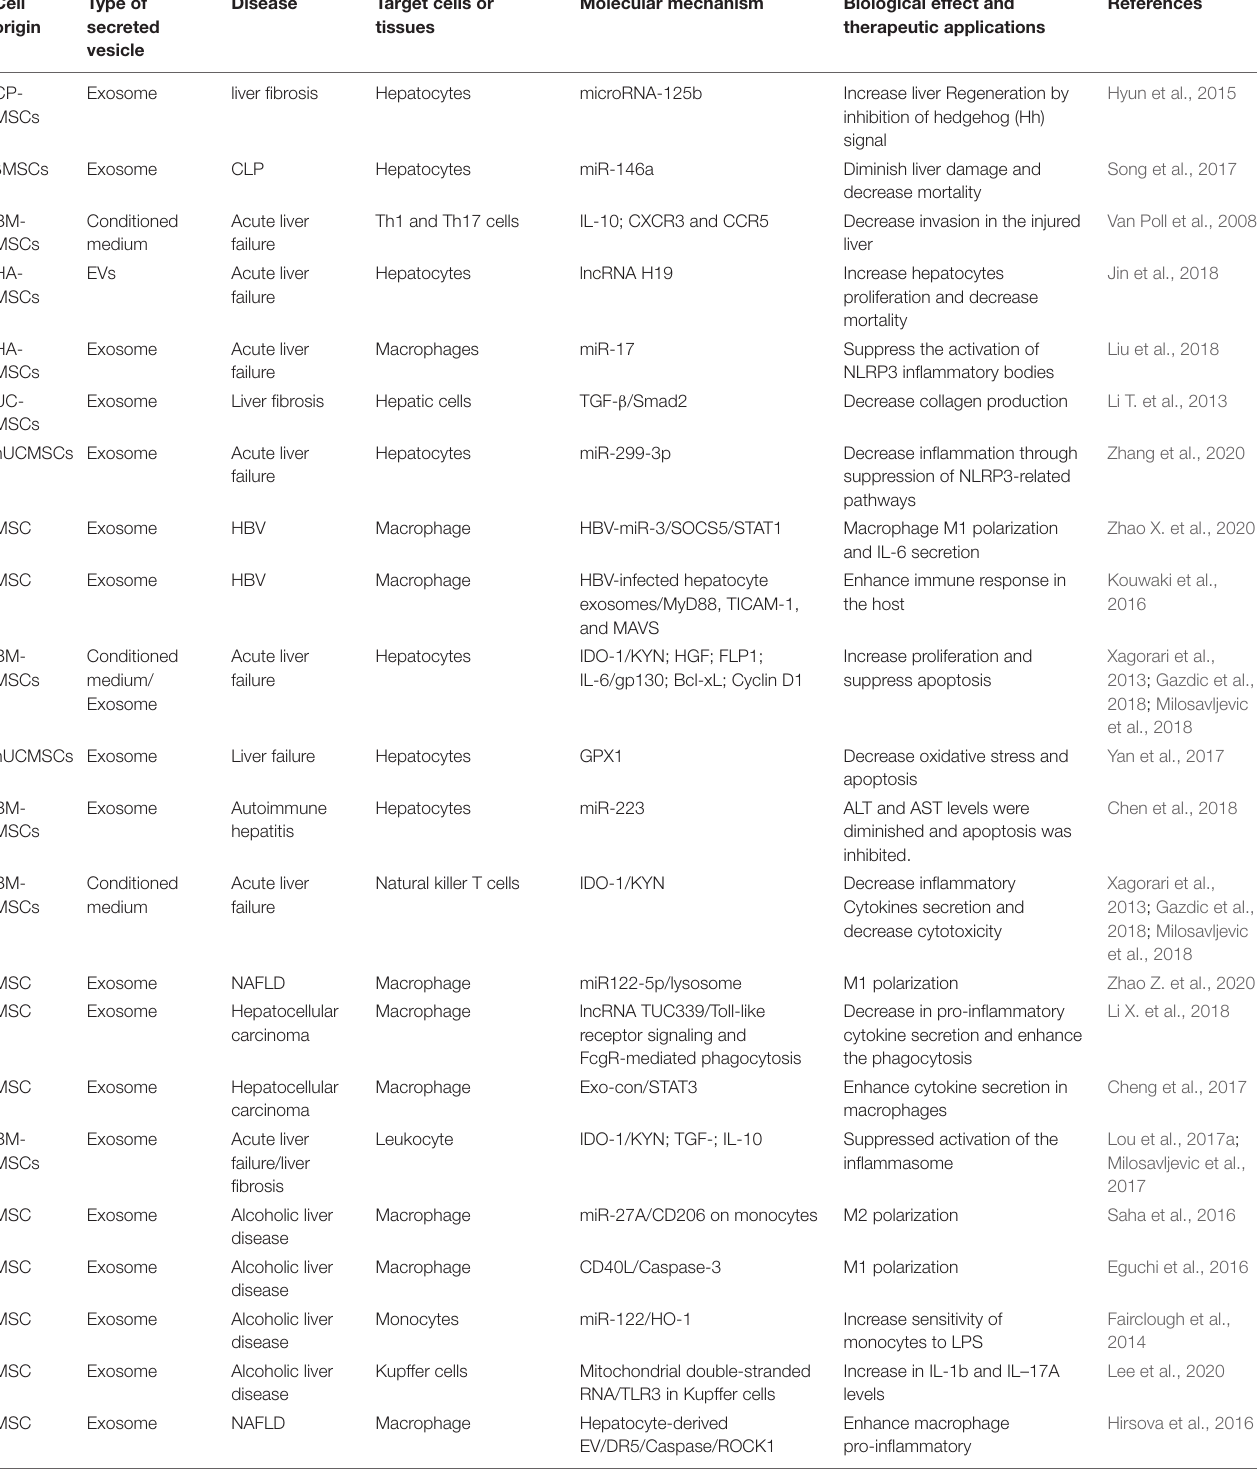
TABLE 1 | Summary of studies which reported the role of extracellular vesicles in the treatment of liver